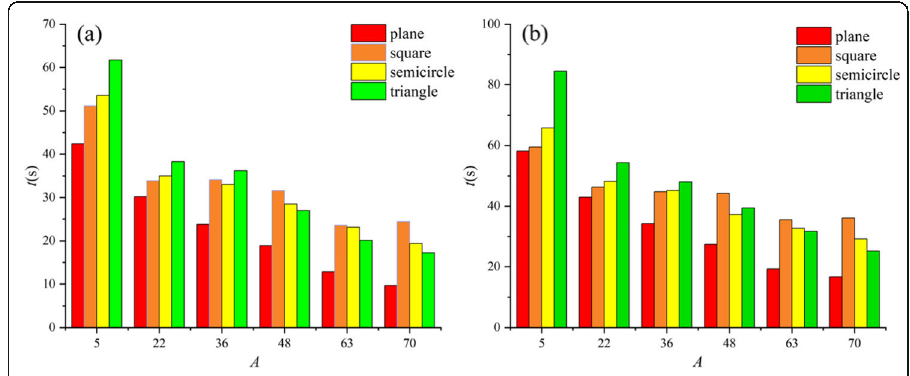
Fig. 8 Freezing time of ( a ) 20ul ( b ) 40ul droplets on surfaces of different